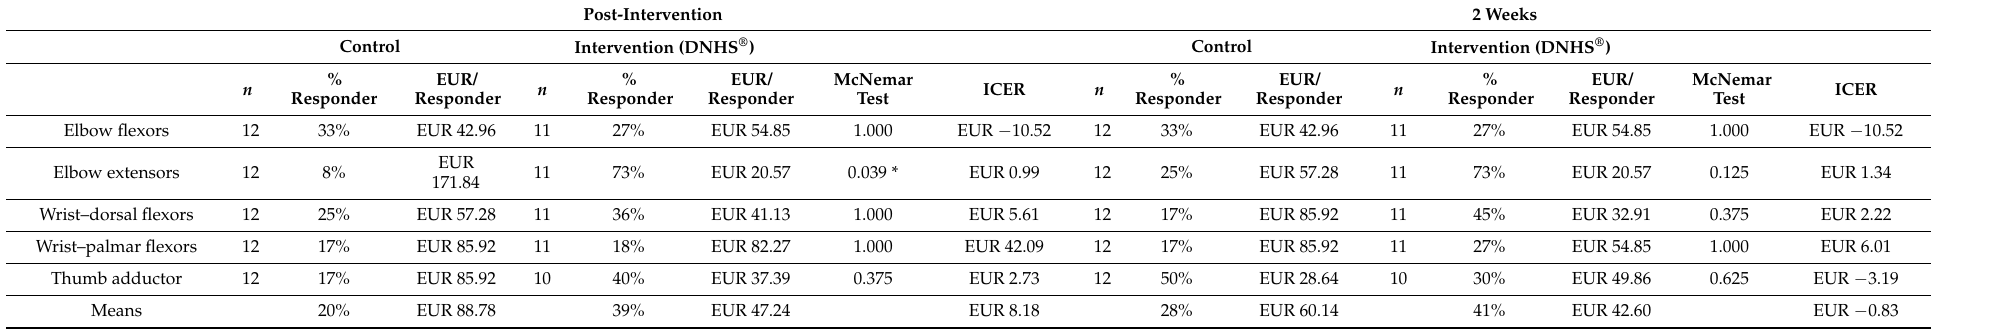
Table 3. Rate of responders to treatment and cost per